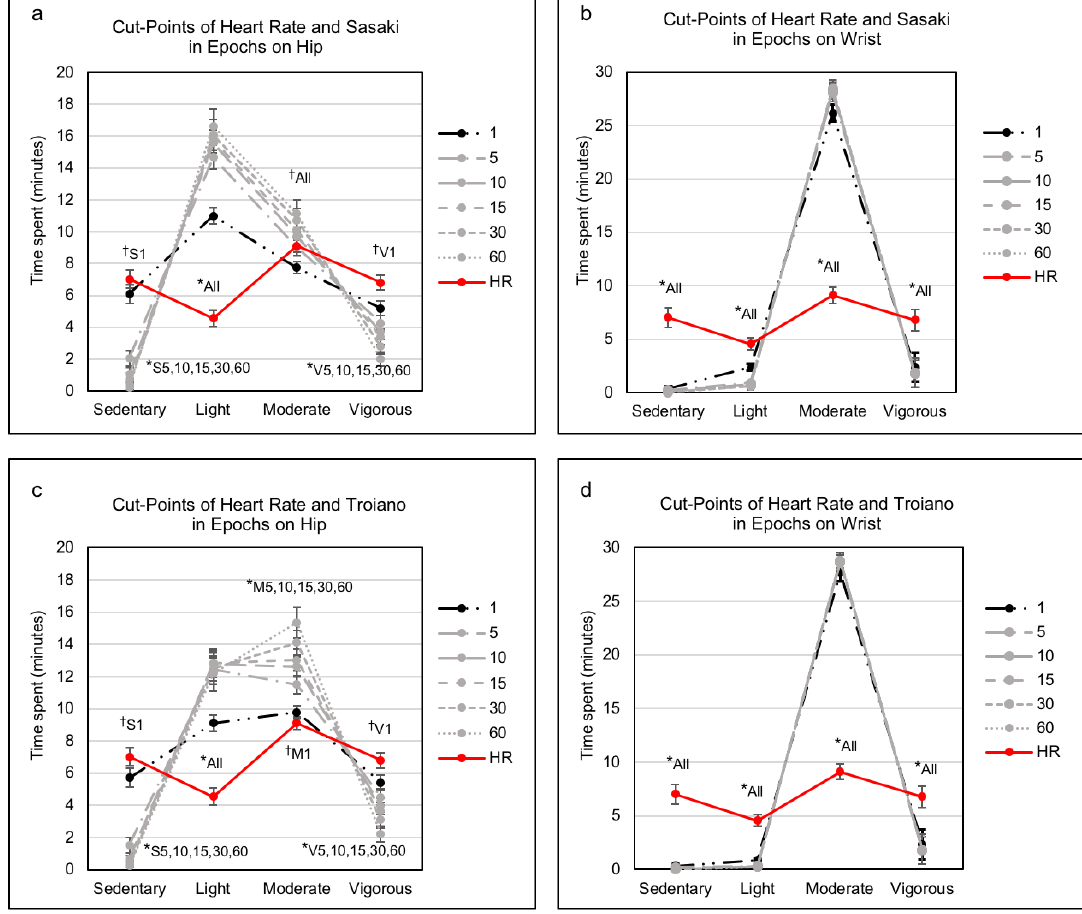
Figure 4. Sedentary and physical activity levels between heart rate and activity counts in epochs. In comparing heart rate, † indicates a nonsignificant difference ( p > 0.05) with an epoch, whereas * denotes a significant difference ( p < 0.001) with epochs. The S, M, and V are indicated as sedentary, moderate, and vigorous, respectively, whereas a number and all are represented as an epoch and all epochs, respectively. HR, heart rate. Data are presented as mean ± standard error in minutes.